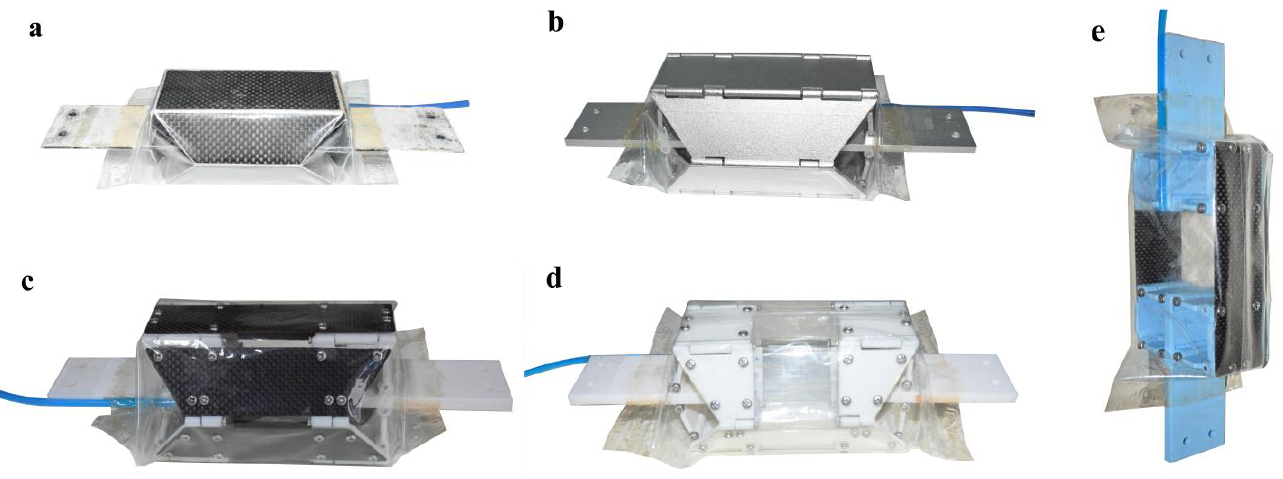
Figure 5. Actuators: ( a ) Actuator with a patched skeleton; ( b ) Actuator with a machined skeleton; ( c ) CFP-beamed actuator; ( d ) PET-beamed actuator; ( e ) Actuator without side support.